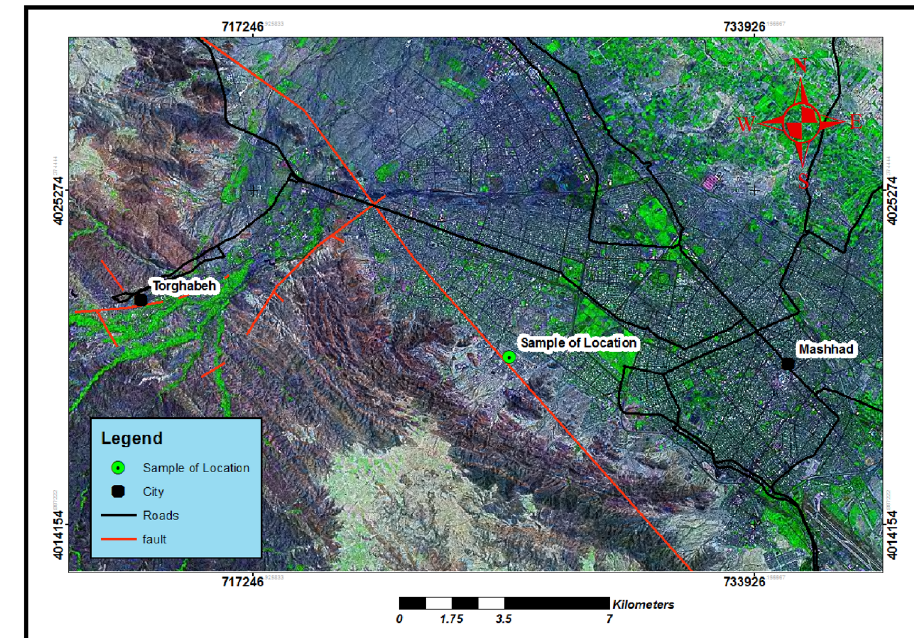
Fig. 1 Location of sampling station in the study